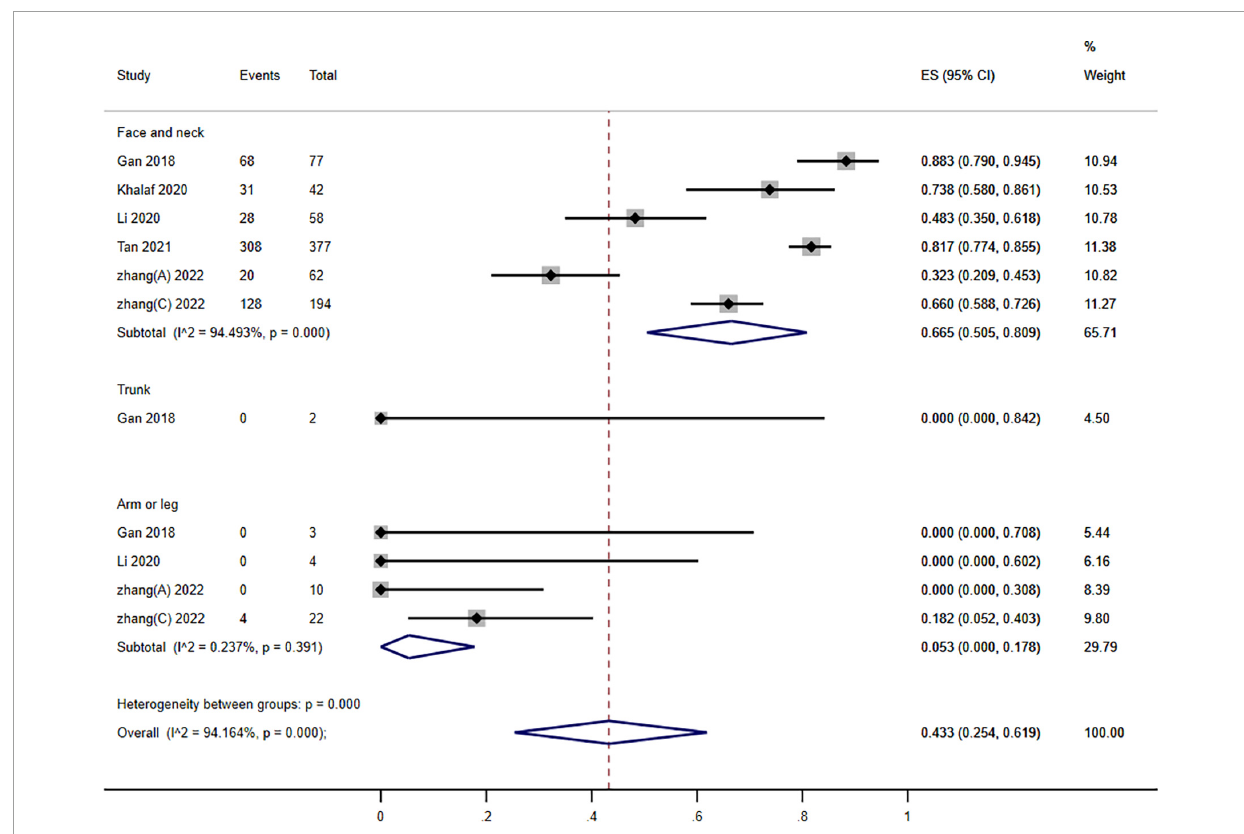
FIGURE5 Forest plot of photodynamic therapy (PDT) effects according to different locations of port wine stains (PWS) ( ≥ 60% improvement).